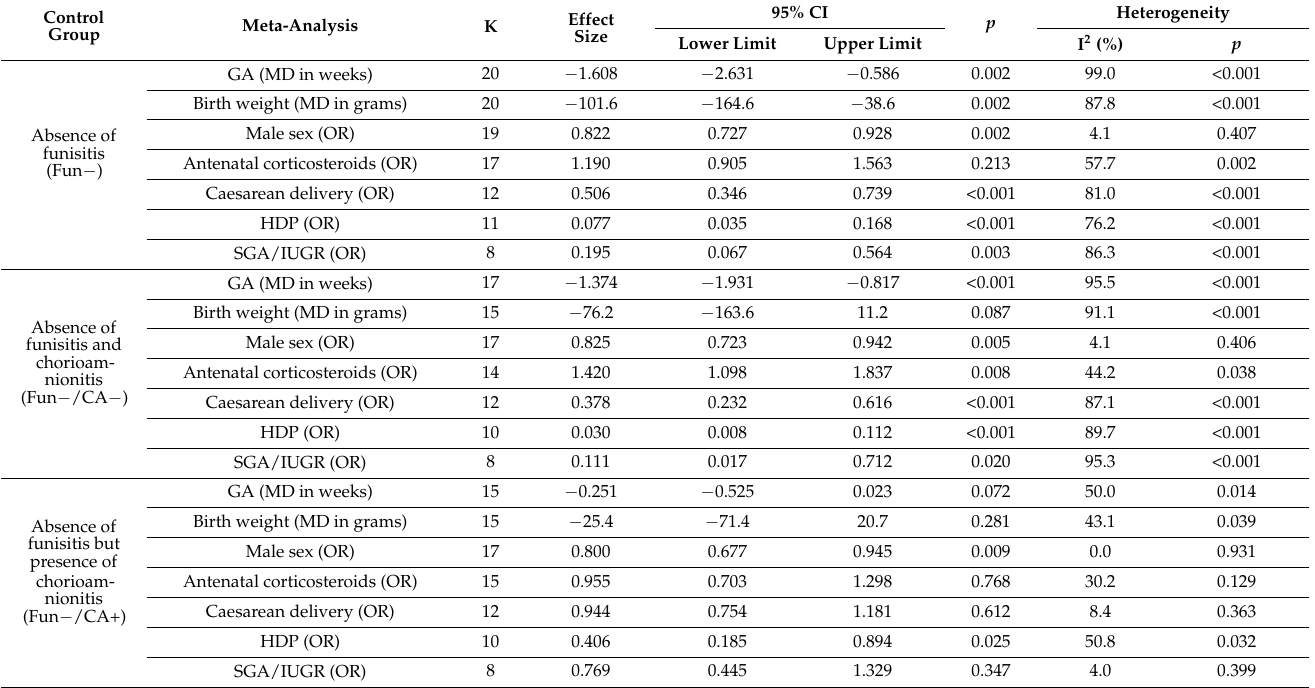
Table 3. Meta-analyses for other